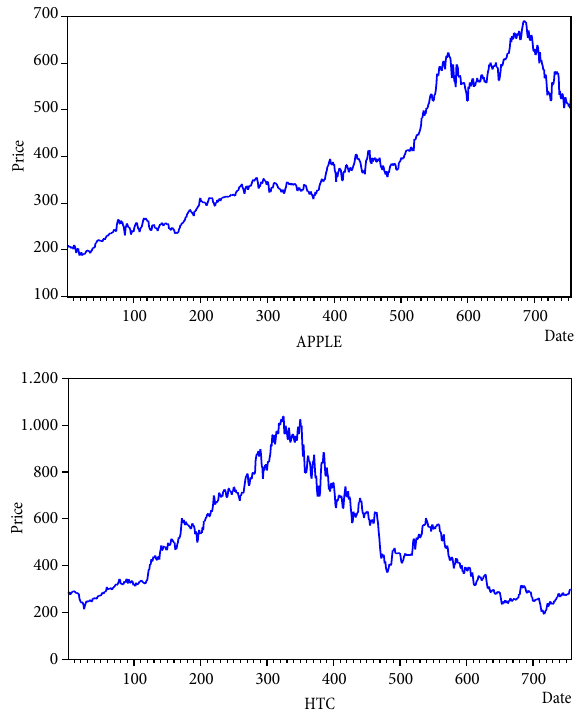
Fig. 1. The trend graph of Apple & HTC stock